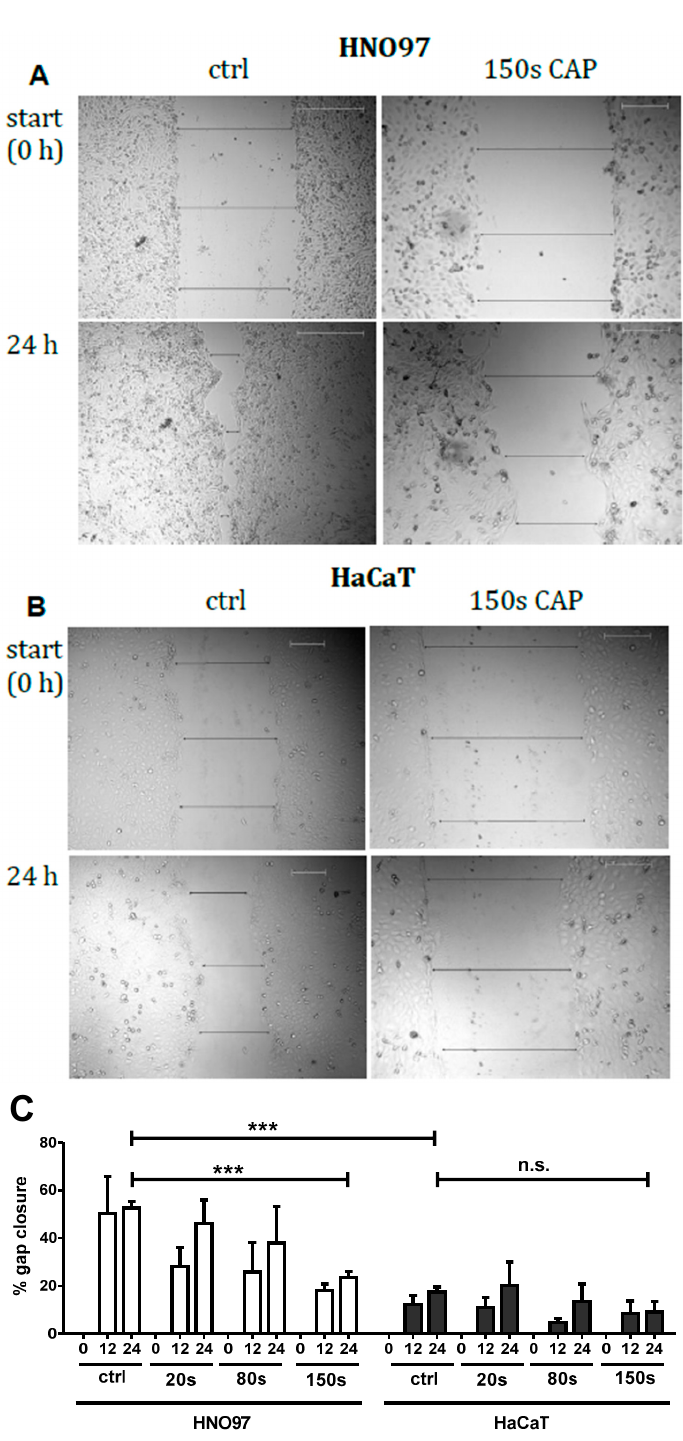
Figure 4. Cell motility was tested in HNO97 cancer cells and HaCaT keratinocytes in response to CAP treatment. Representative microscopic photographs of a scratch assay are depicted for ( A ) HNO97 and ( B ) HaCaT keratinocytes. Cell motility was evaluated as gap closure in % of the initial distance after 12 and 24 h, respectively and displayed as bar graph ( C ) for both cell lines. HaCaT keratinocytes are significantly less motile compared to their malignant counterpart HNO97 (compare both ctrl). Addition of CAP treated medium reduced cell motility significantly in HNO97 (empty bars) while HaCaT keratinocytes are not a ff ected (dark bars). The assay was performed at least in triplicates. Bars represent mean + SD. Magnification ×